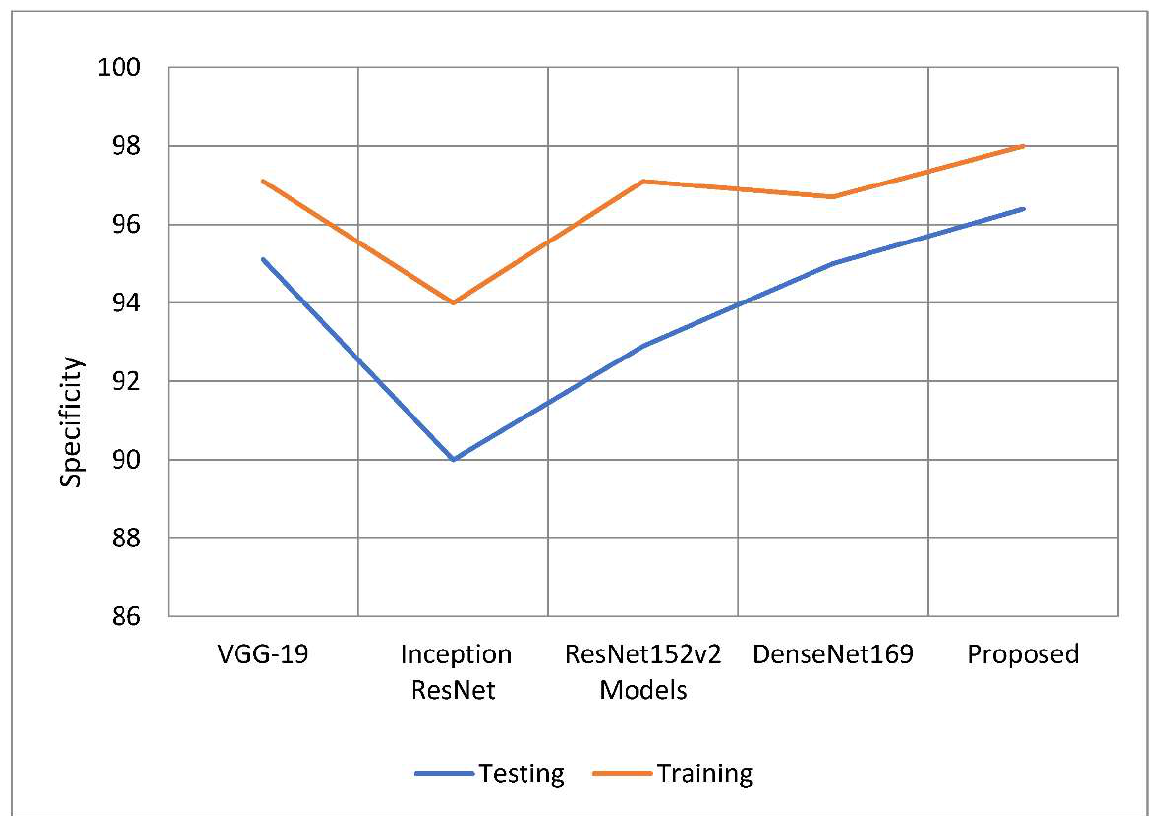
Figure 10. A comparative analysis of recall of the proposed model with traditional models.